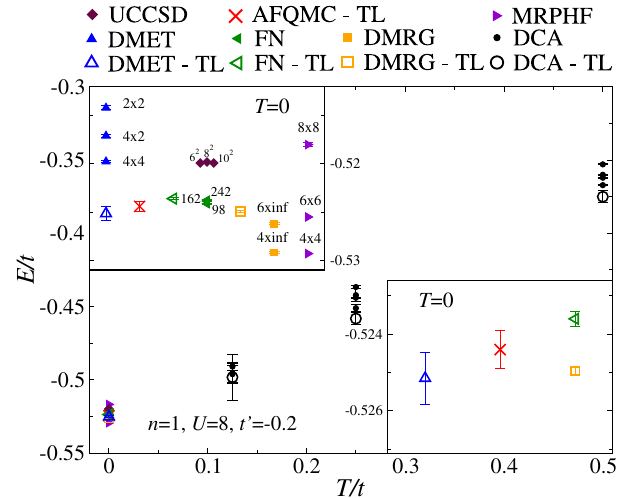
FIG. 8. Data for n ¼ 1 for U=t ¼ 8 with t 0 =t ¼ − 0 . 2 . Main panel: Temperature dependence of E=t compiled from various techniques. Solid symbols represent finite systems; open symbols represent extrapolations to the thermodynamic limit. Finite- T results are shown for DCA (black circles), and zero- T data from AFQMC (red crosses), DMET (blue triangles), UCCSD (maroon diamonds), MRPHF (purple triangles), DMRG (orange squares), and FN (green triangles). Top left inset: Zoom-in of the zero- T data from MRPHF, UCCSD, DMET, FN, DMRG, and AFQMC, including finite-system-size data (as labeled) for MRPHF, FN, DMET, and DMRG. Bottom right panel: Enlarged region of the top left inset showing DMET, DMRG, FN, and AFQMC data at T ¼ 0 , including error bars, extrapolated to the infinite system